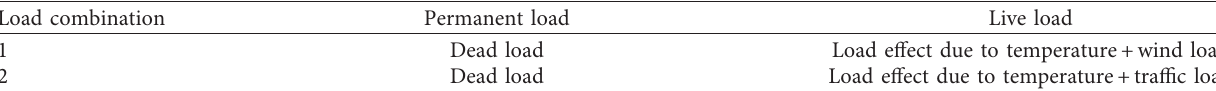
Table 5: Combination of load